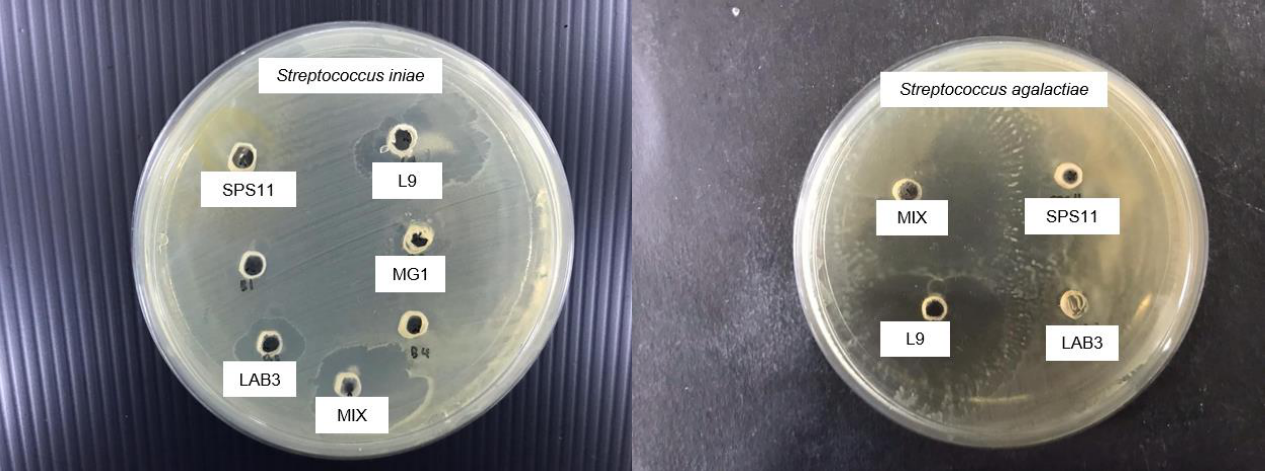
Figure 1. The inhibition zones demonstrated by probiotic Lysinibacillus fusiformis SPS11, Bacillus amyloliquefaciens L9, Enterococcus hirae LAB3, MP, and MG1 against Streptococcus iniae and SPS11, L9, LAB3, and MP against Streptococcus agalactiae . Table 3. Mean ± SEM of inhibition zones in mm of different probiotics against Streptococcus agalactiae and Streptococcus iniae at two different concentrations.